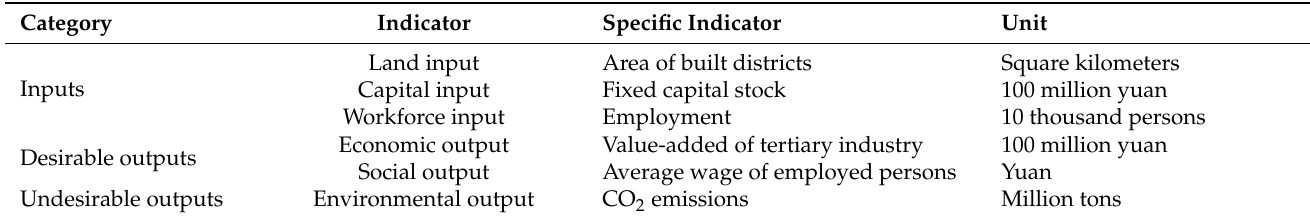
Table 2. Indicator system for evaluating